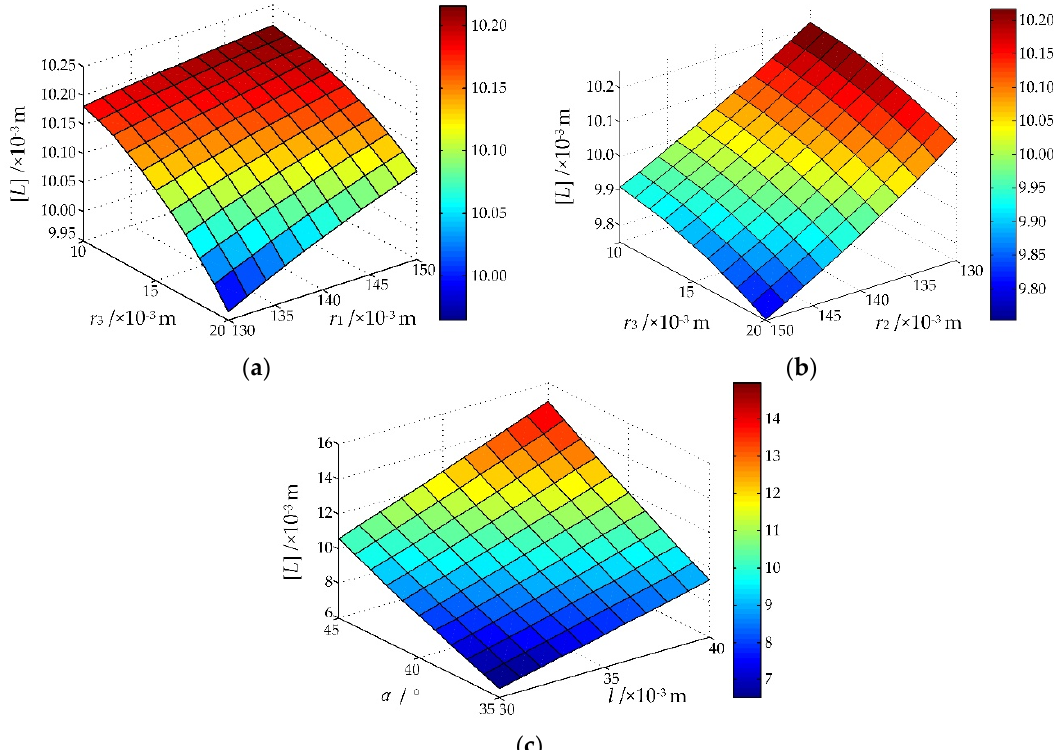
Figure 11. The permissible stroke of the locking tab with ( a ) the effects of r 1 and r 3 ; ( b ) the effects of r 2 and r 3 ; ( c ) the effects of l and α .